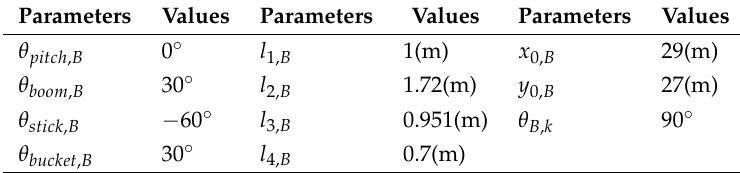
Table 3. Posture Parameters of Simulation: Excavator B nearby warning